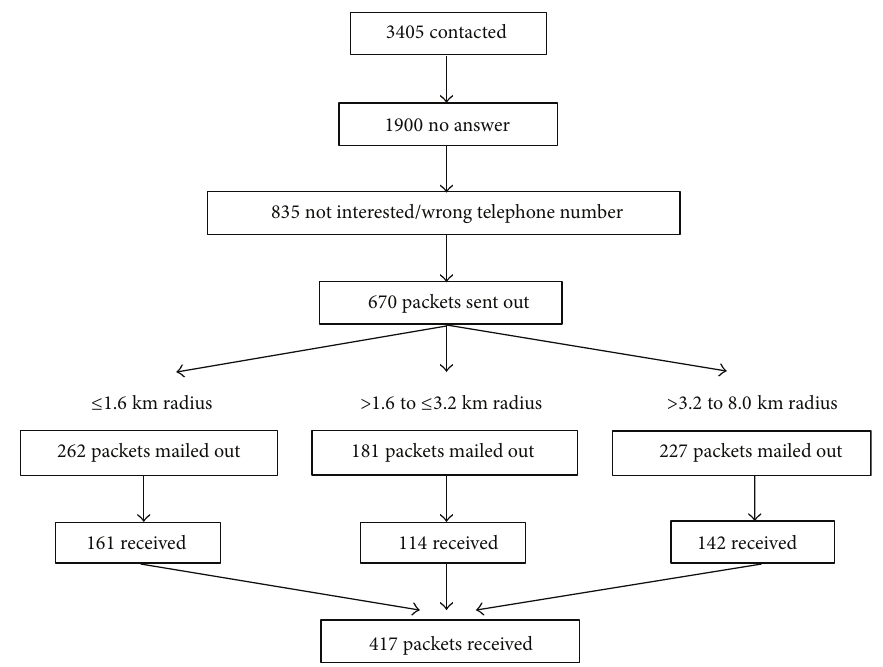
Figure 1: Participant flow